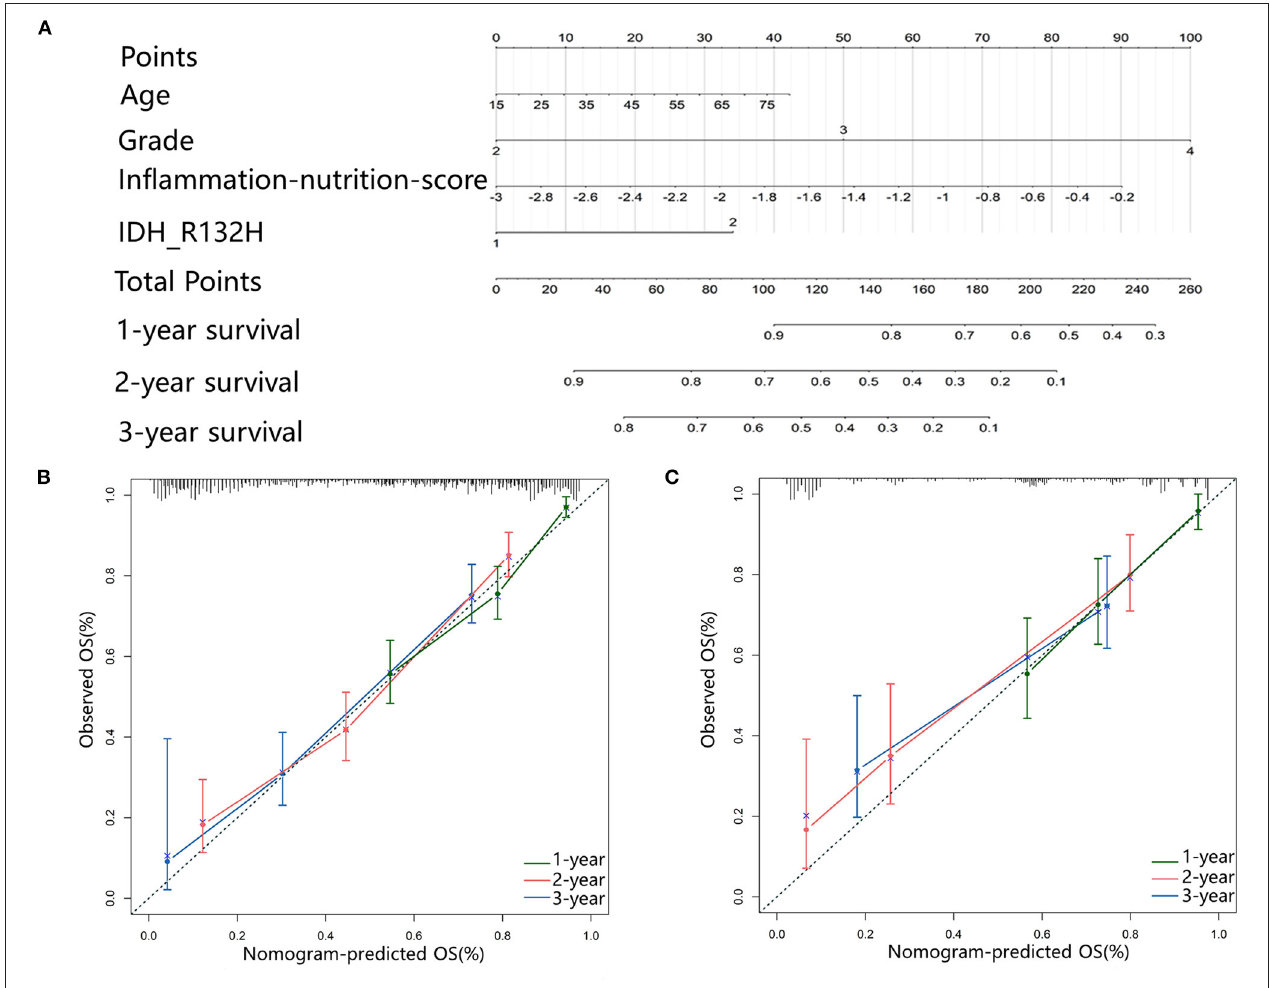
FIGURE 3 | (A) Nomogram for predicting the 1-, 3-, and 5-year prognosis for patients with Gliomas. (B,C) Calibration plots represent the consistency between the predicted results and the observations calibrated for each model. They showed the accuracy of nomogram regarding to 1-, 3-, and 5-year OS both in primary (B) and validation (C) cohort. Dashed line at 45 ◦ represents perfect prediction, and the actual performances of our nomogram are red, blue, and green